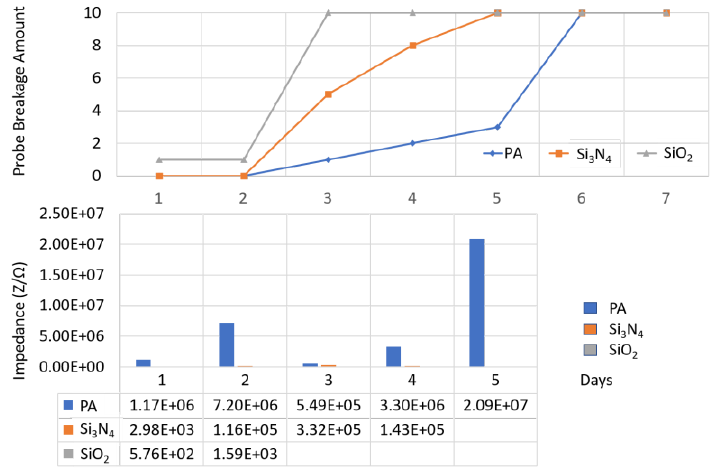
Figure 7. Average impedance change and wire breakage for samples with a single layer coating (1 µm) of PA, Si 3 N 4 , and SiO 2 , tested at 67 °C, 1 kHz, PBS + H 2 O 2 (150 mM).